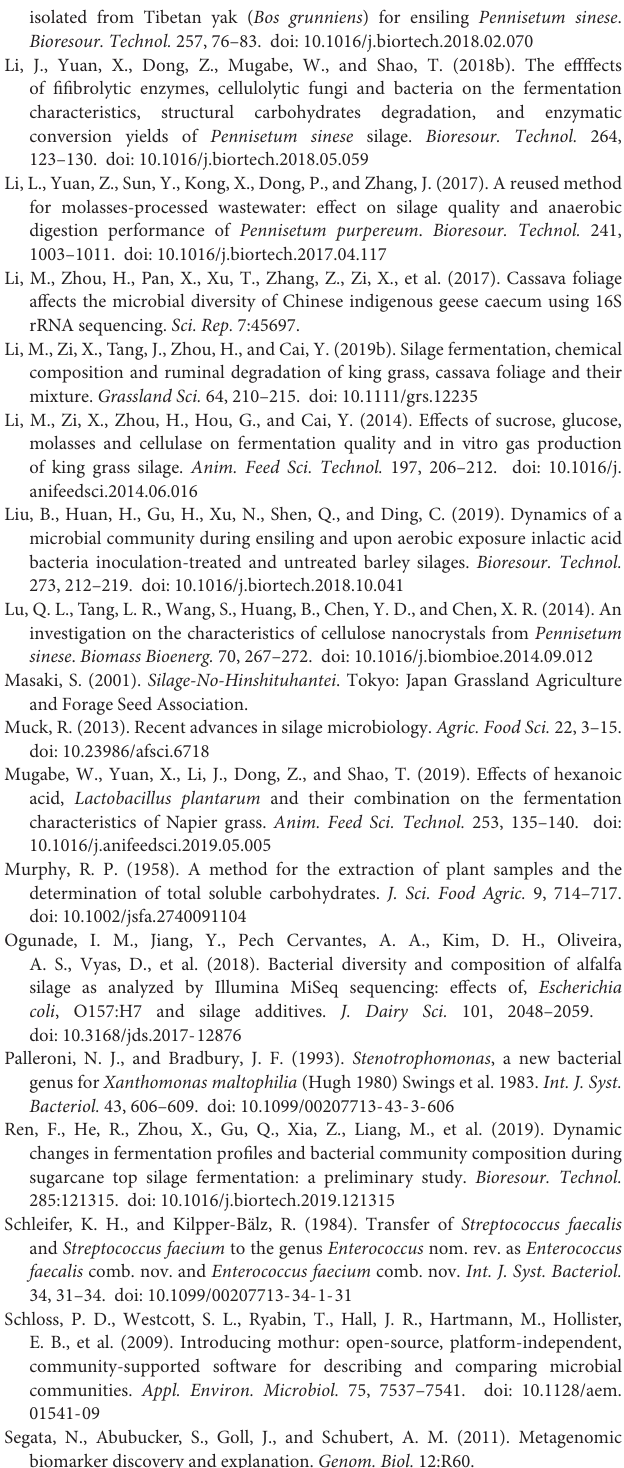
Supplementary Table 1 | Environmental factors effecting the 12 varieties of P. sinese. MIN, Pennisetum purpureum Schum. cv. Gui Min Yin; TW, Pennisetum purpureum Schumab ev. Taiwan; MOTT, Pennisetum purpureum cv. Mott; KG, Pennisetum purpureum × P . glaucum cv. Reyan No. 4; DY,